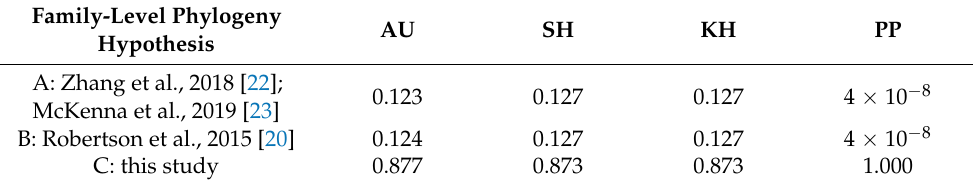
Figure 11. Family-level phylogeny hypothesis of seven families [22,23]. Table 3. Phylogenetic hypothesis testing.